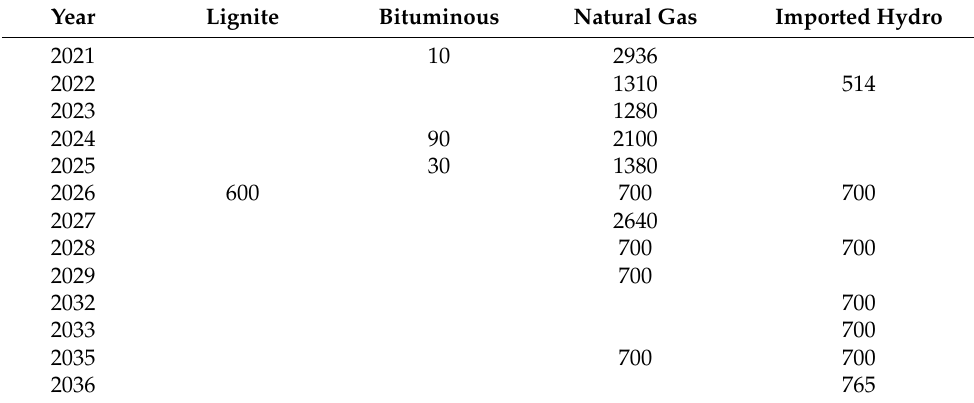
Table A5. Committed conventional generation units (MW).